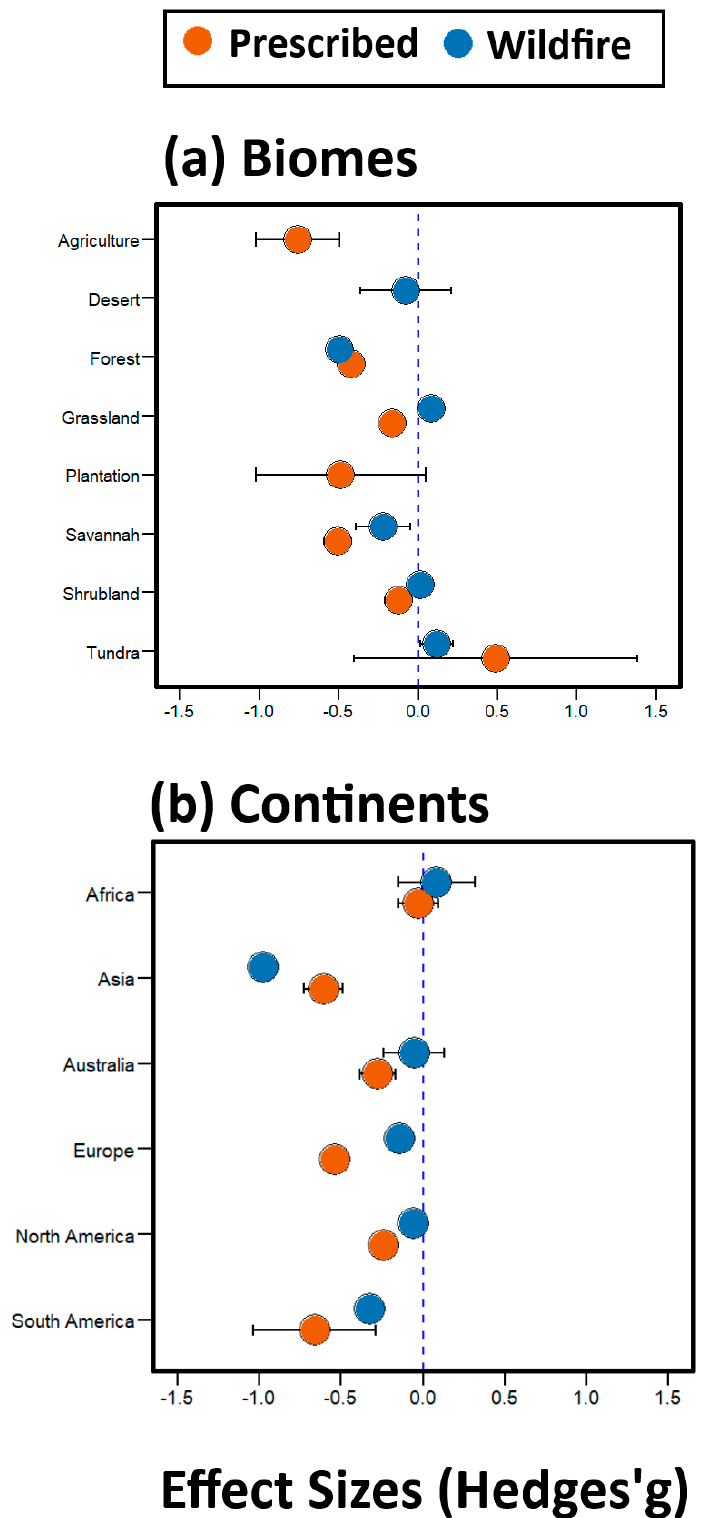
Figure 7. Overall effect of fire on ( a ) biomes ( b ) continents of all faunal groups. Circles denote the Hedges’ g value and lines denote the 95% confidence intervals (CI) for each Hedges’ g value.